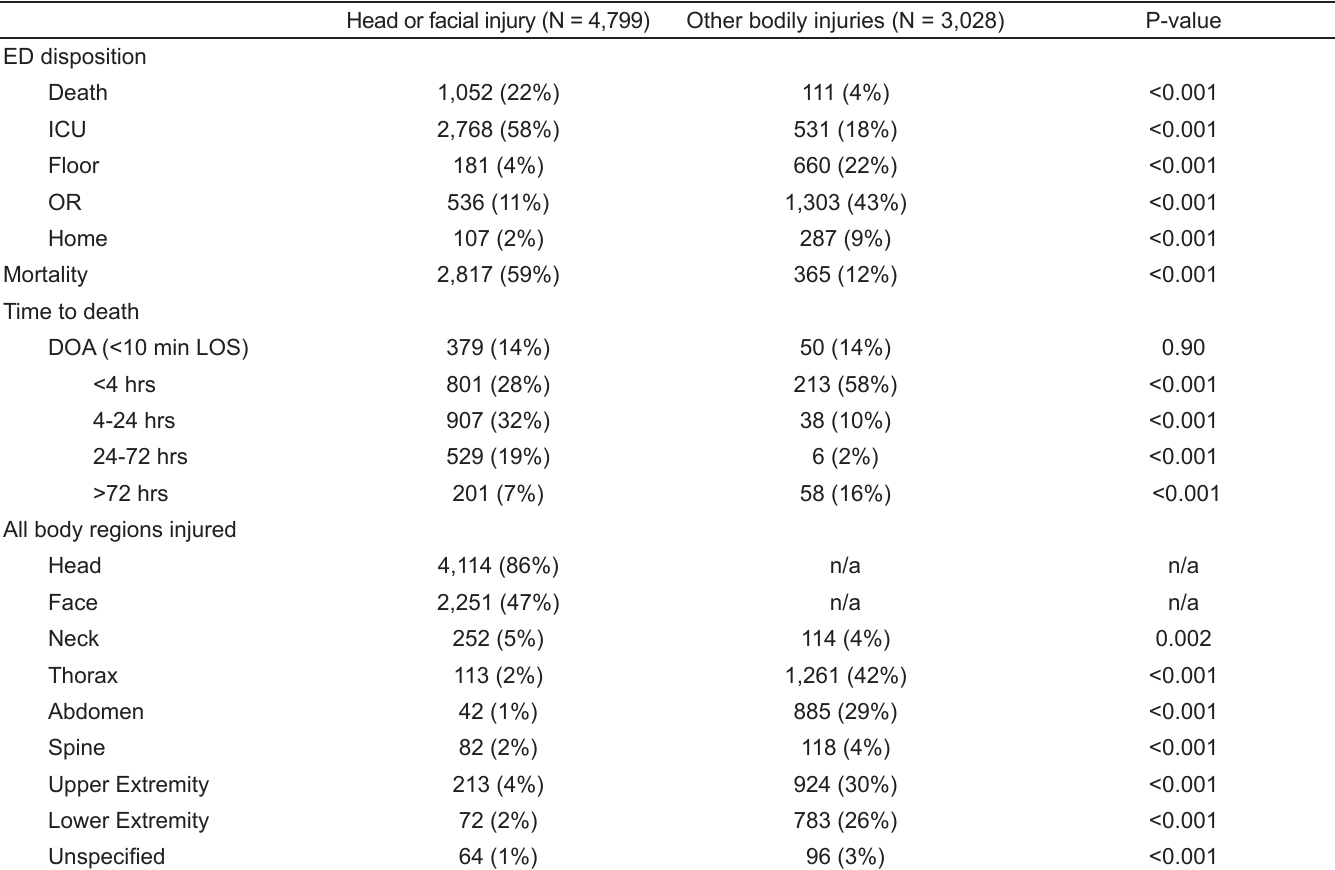
Table 2. Outcomes of head and facial injuries versus those with other body injuries excluding head and face.